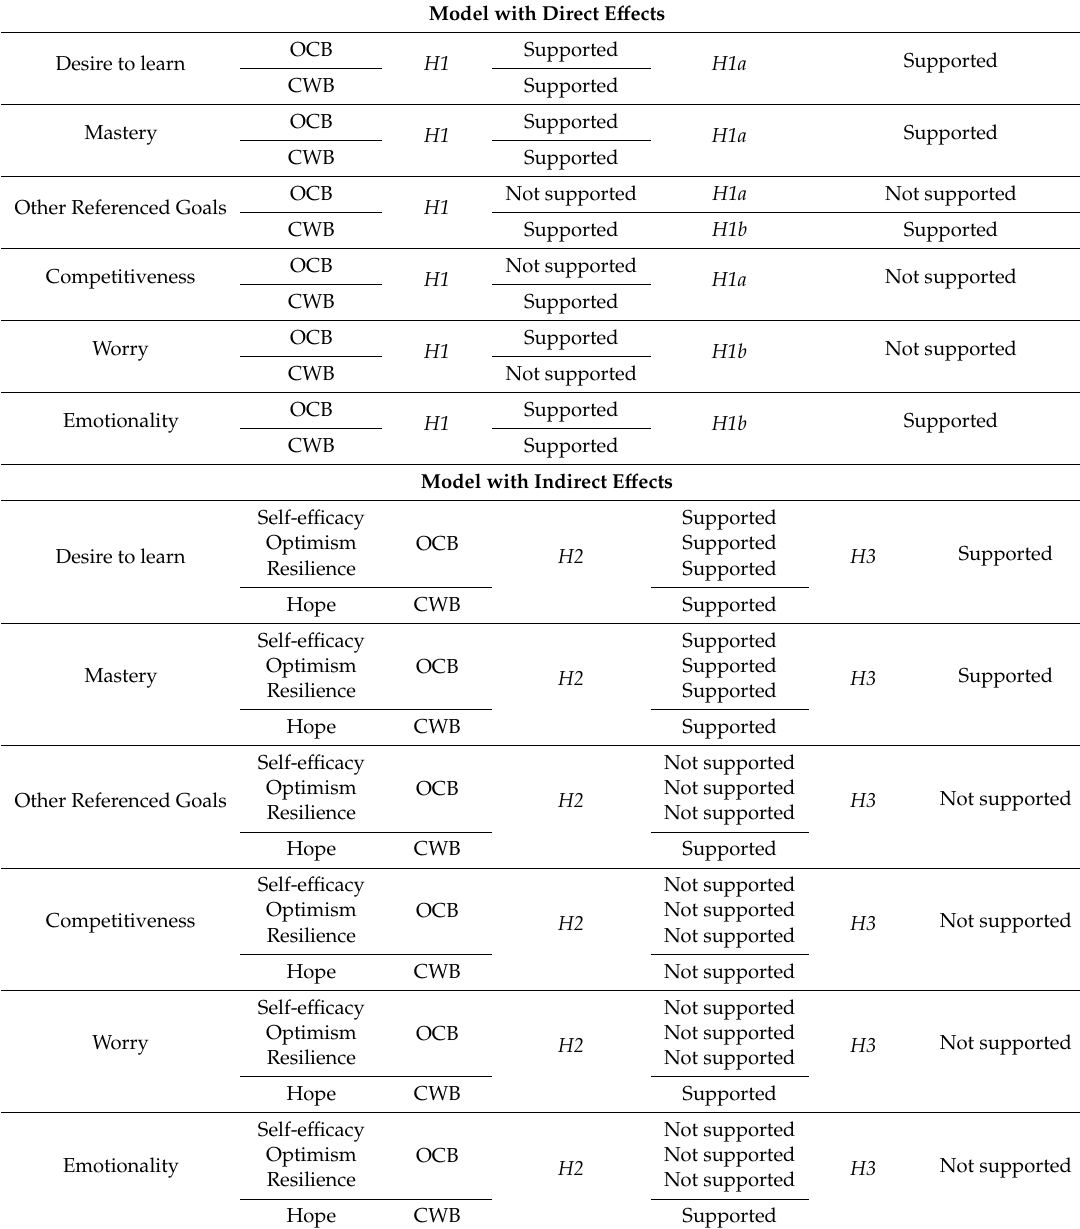
Table 2. Results of hypotheses testing ( n =